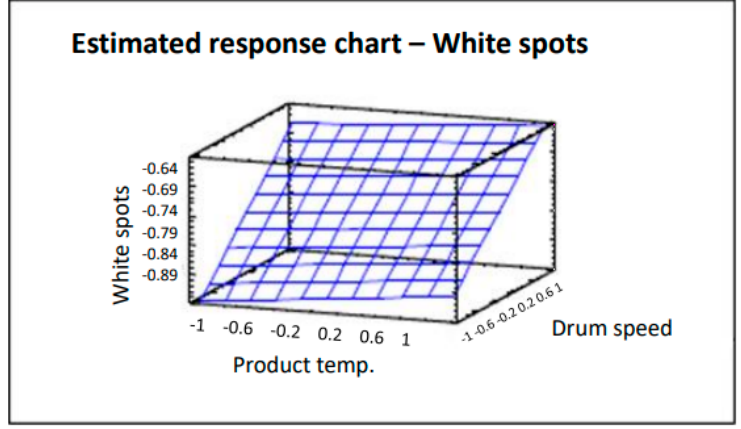
Figure 6. Estimated response chart—White spots.